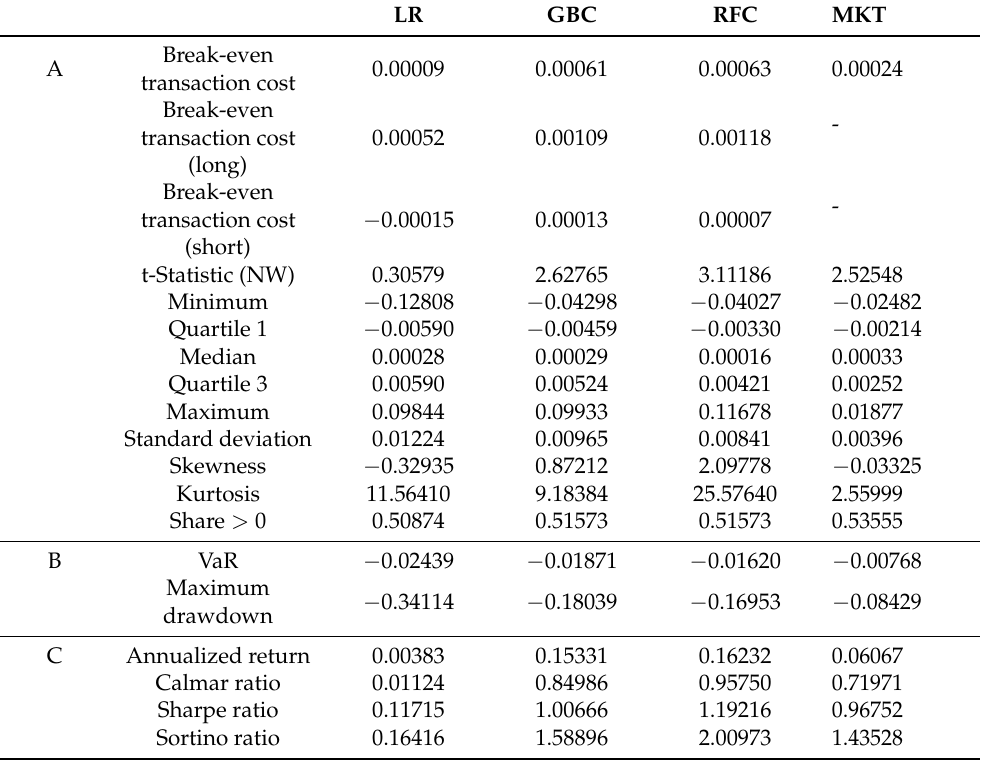
Table 1. Strategy performance of baseline scenario. Daily return characteristics (Panel A), daily risk characteristics (Panel B) and annualized risk-return metrics (Panel C) for the logistic regression (LR), gradient-boosting classifier (GBC), random forest (RF) and general market (MKT). Performance characteristics are illustrated for the top/flop three trading strategy ( k = 3 ) and a holding period of one day ( h = 1 ) . NW denotes Newey–West standard errors with one-lag correction. Daily value at risk (VaR) is calculated at the 95.0 percent confidence